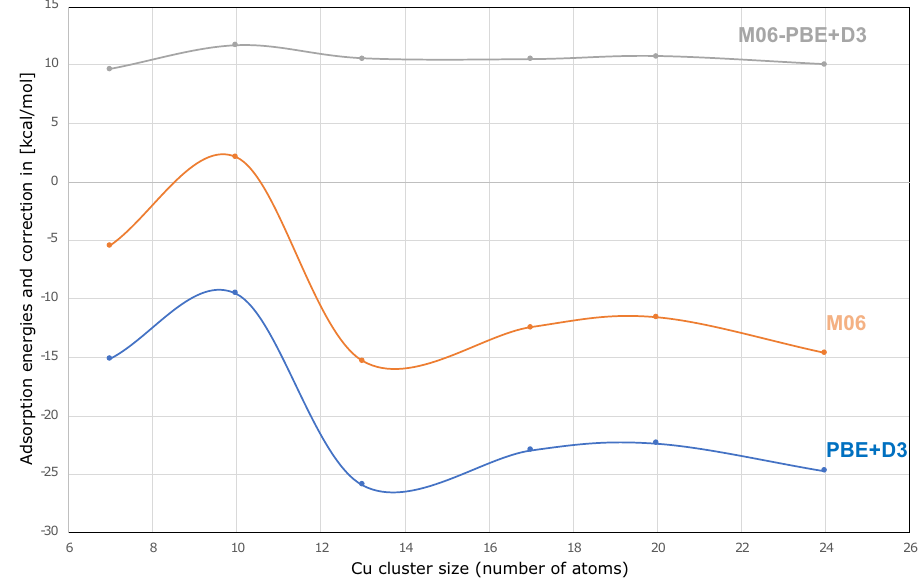
Fig. 6 | Clustercorrectiondependsweakly onclustersize. Adsorption energy of CO on Cu clusters with increasing number of atoms using M06 (orange) and PBE +D3 (blue).The employed correction to the PBC adsorption energy, E(M06)-E(PBE +D3), is shown in gray. The variation of the adsorption energy vs. the number of